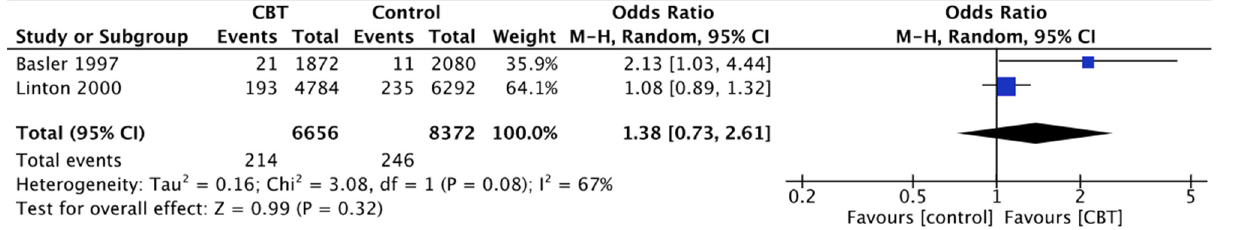
Figure 14. Days without pain: CBT versus control.